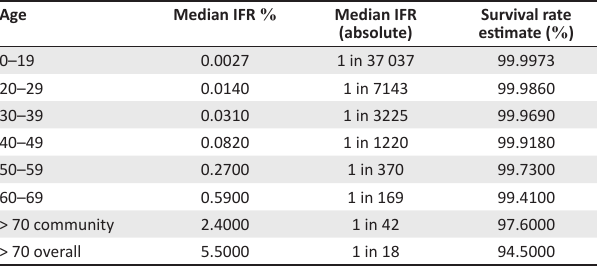
TABLE 1: Infection fatality rate of ancestral variants of COVID-19 pre-vaccination by age. Age Median IFR %